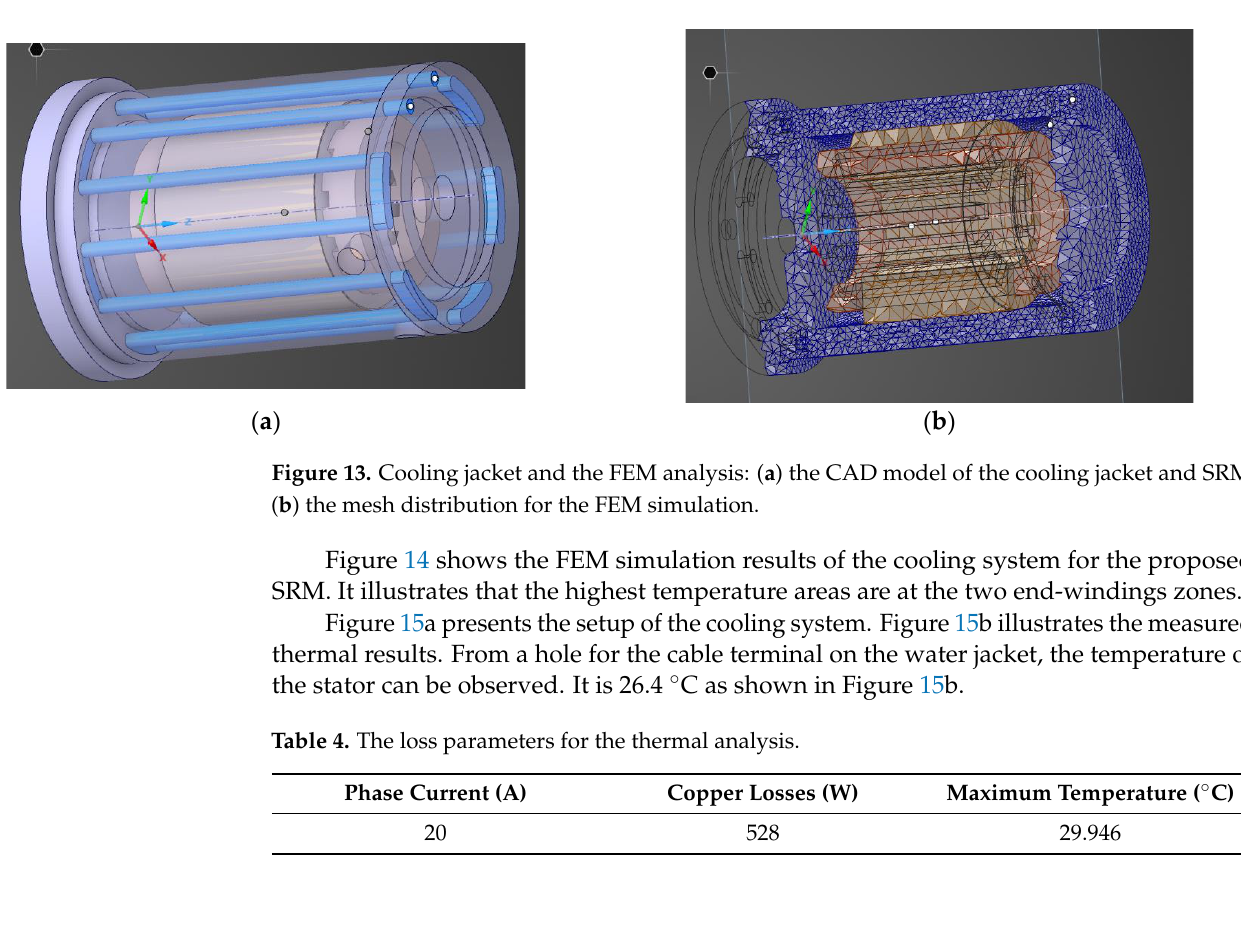
Figure 14. The FEM thermal simulation of the liquid cooling jacket.